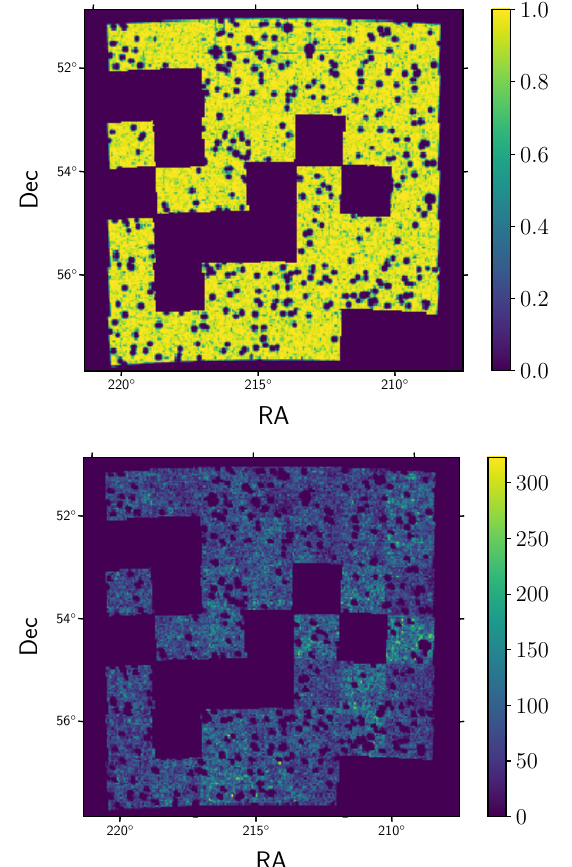
Figure 2. Example of masks used in this analysis for the W3 field. The top figure is the mask without including the lensfit weights. The bottom panel is the weights map for the sixth redshift bin.